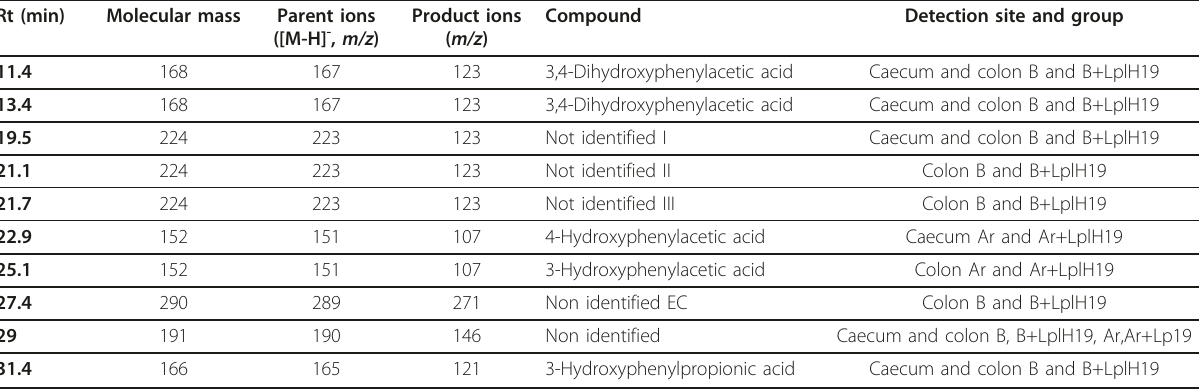
Table 2 Aromatic acid metabolites detected in caecum and colon of mice administrated billberry (B) or chokeberry (Ar) alone or supplemented with strain L. plantarum HEAL19 (LplH19) Rt